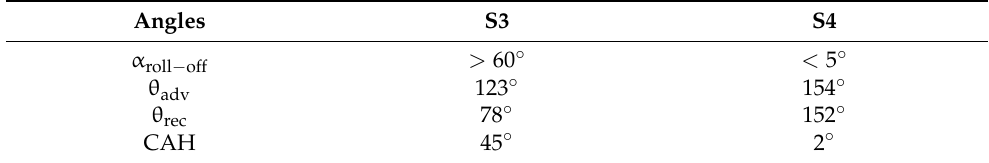
Table 5. The roll-off water angles ( α (cid:2928)(cid:2925)(cid:2922)(cid:2922)(cid:2879)(cid:2925)(cid:2916)(cid:2916) ), the advancing contact angle ( θ (cid:2911)(cid:2914)(cid:2932) ), the receding contact angle ( θ (cid:2928)(cid:2915)(cid:2913) ), and the contact angle of hysteresis (CAH) of the S3 and S4 samples. Angles